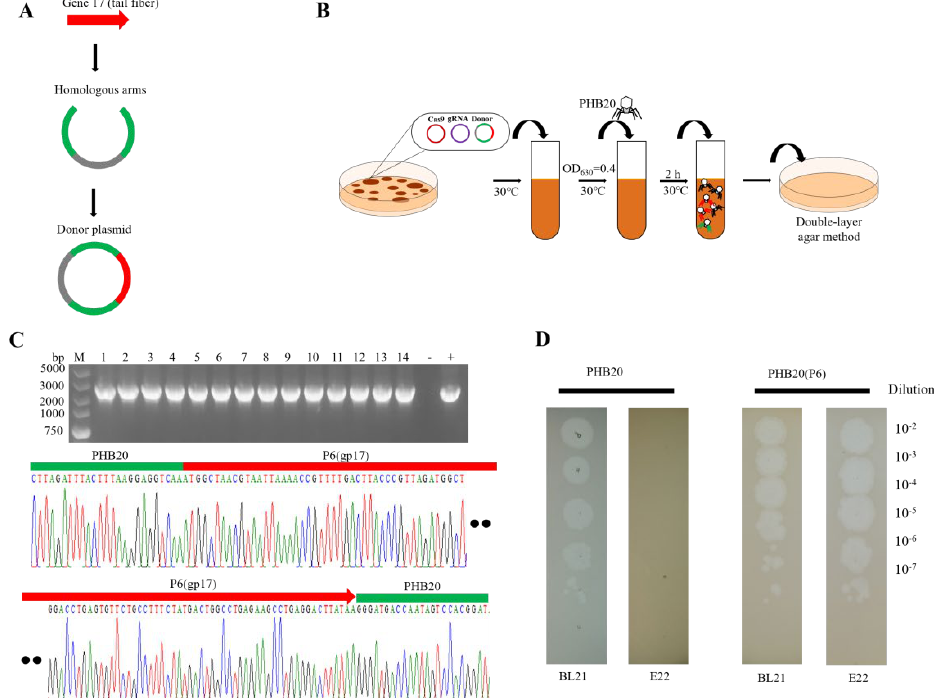
Figure 3. Recombinant phage PHB20. ( A ) Construction of donor plasmids. All phage-tail fiber gene templates were performed using the CloneExpress ® II One Step Cloning Kit. ( B ) Schematic overview of the workflow of PHB20 genome editing. ( C ) Sanger sequencing of the target genes. The numbers 1 − 14 represent recombinant phages. ( D ) Plaquing assay with WT − PHB20 and engineered